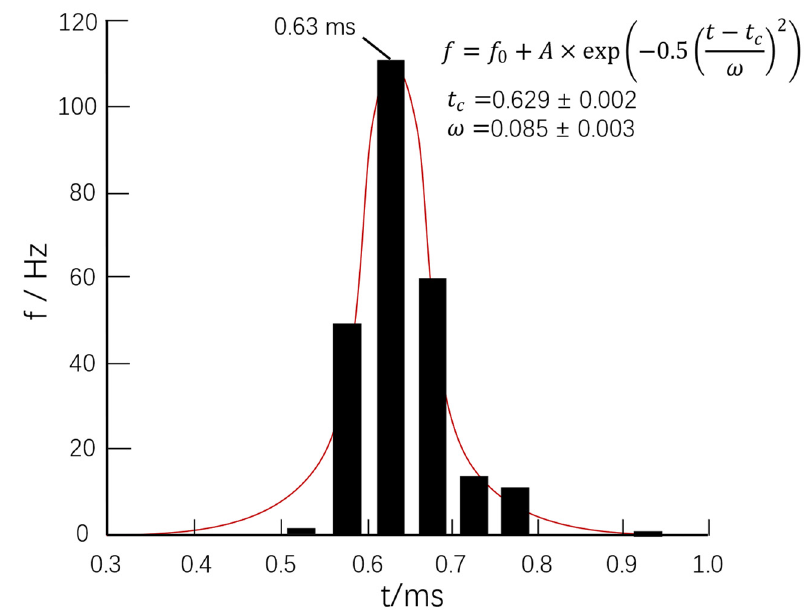
Figure 16. Time-consuming histogram of the single step.